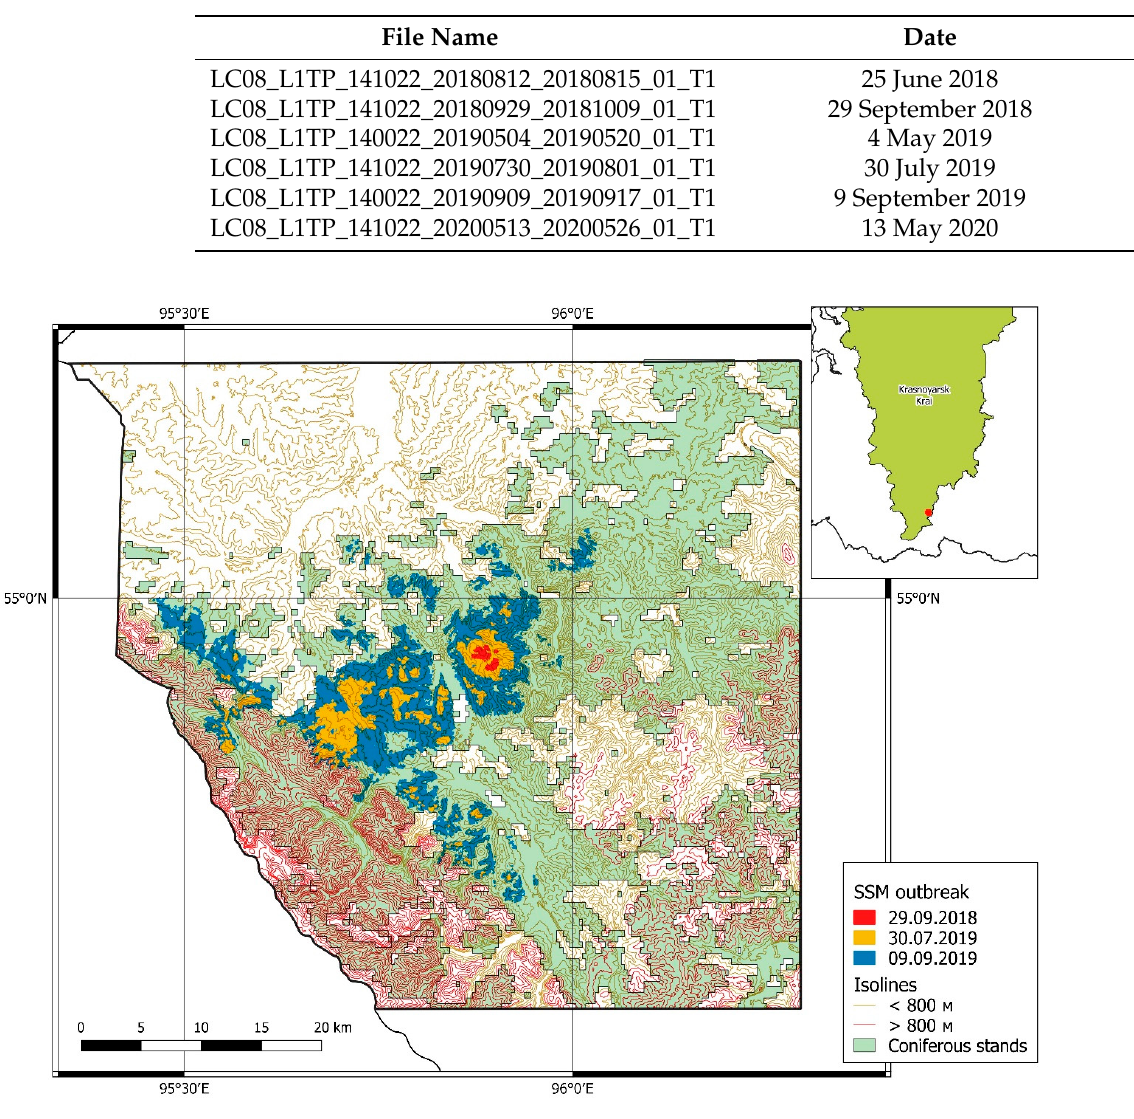
Figure 2. Study area showing the extents from Landsat-8 images, survey polygons of dark coniferous forests damaged by the Siberian silk moth. Legend: red, yellow, and blue backgrounds show the areas of forest stands damaged by the pest (defoliation of 50% or more) on a specific date – 29 September 2018, 30 July 2019, 9 September 2019, respectively; green background – areas occupied by coniferous plantations (potential host-trees of the pest); the relief in the form of brown isolines is shown at altitudes up to 800 m, red lines – at an altitude of more than 800 m.